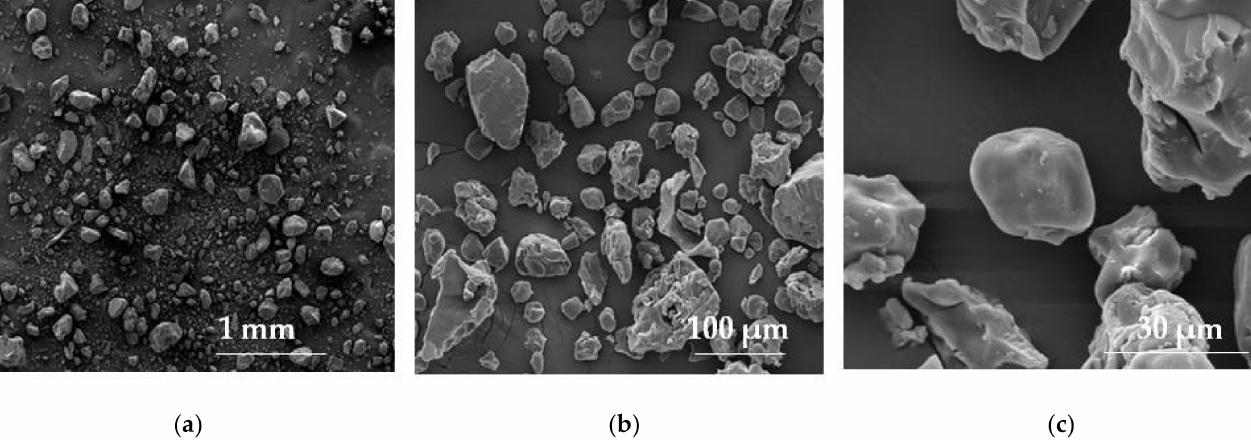
Figure 4. SEM picture of pregelatinized maize starch (StarCap 1500) under magnification: ( a )100 × , ( b ) 1000 × , ( c ) 5000 × (photographs of the authors made with Inspect™S50, FEI Company, Hillsboro, OR,